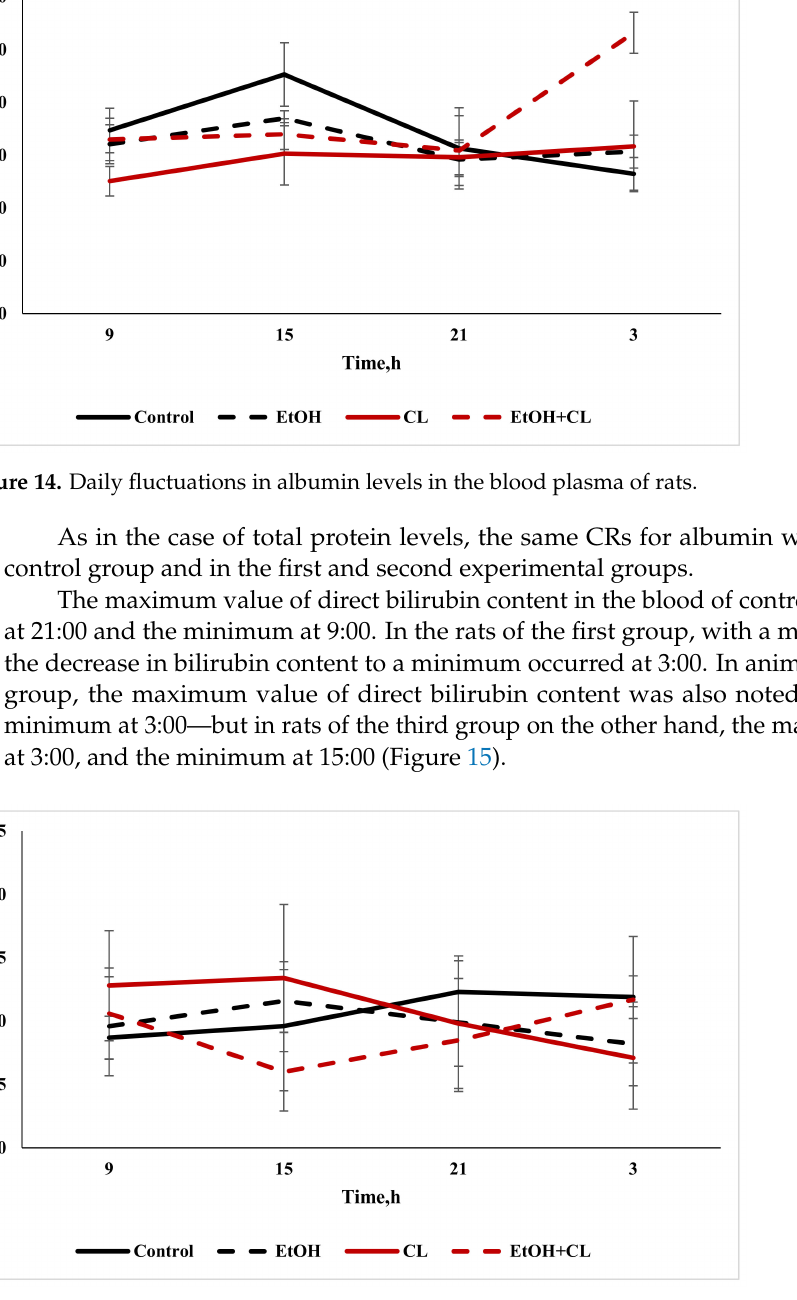
Figure 15. Daily fluctuations of direct bilirubin content in the blood plasma of